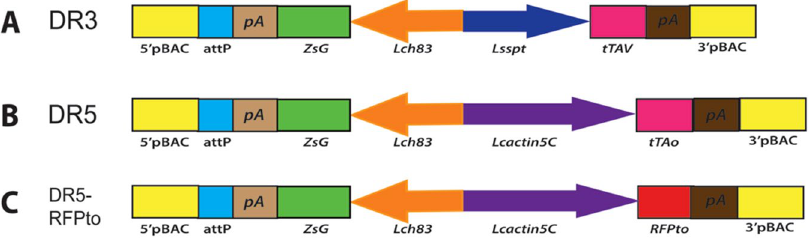
Figure 1. Schematic illustration of the driver constructs. All constructs contain the ZsGreen marker driven by the Lchsp83 gene promoter, a phiC31 attP site and 5 ′ and 3 ′ piggyBac ends. Expression of tTA is controlled by the Lsspt promoter in DR3 ( A ) and the Lcact5C promoter in DR5 ( B ). The Lcact5C promoter was also used to drive expression of the dtTomato (RFPto) reporter gene ( C ).